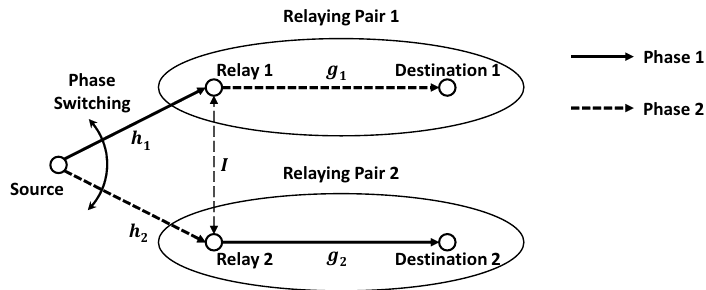
Figure 2. Conventional two-path successive relaying (TPSR) protocol